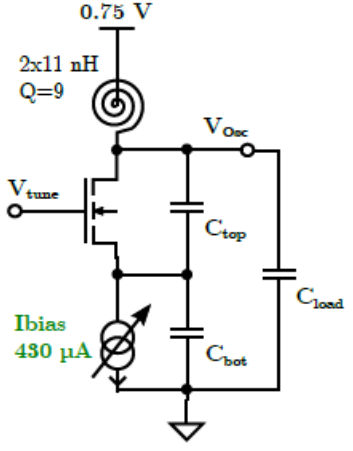
Figure 3. Circuit architecture of the Colpitts oscillator.